Question: Provide a one-line summary of what is displayed.
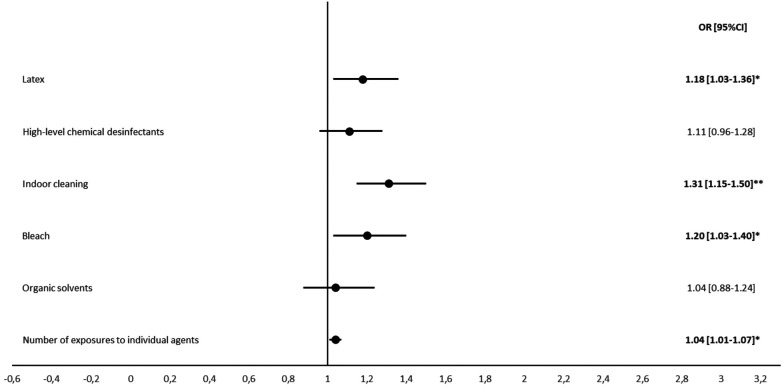
Answer: Associations between occupational exposure (individual agents) and self-reported moderate-to-very severe hand eczema at worst in the past year vs. no self-reported hand eczema in lifetime ( N = 49,995). Adjusted for sex, age and self-reported physician diagnosed atopic dermatitis. Data on occupational exposure was derived from linkage with the Occupational Asthma-specific job exposure matrix by Kennedy et al. and Le Moual et al., according to most recently reported International Standard Classification of Occupations version 2008 (ISCO-08) coded occupation ( 10 , 11 , 18 ). Binary logistic regression analyses were only presented when at least 100 cases and controls were available. P -values ≤0.05 are shown in bold. *Significant at 0.05 level, **Significant at 0.001 level. CI, confidence interval; OR, Odds ratio.